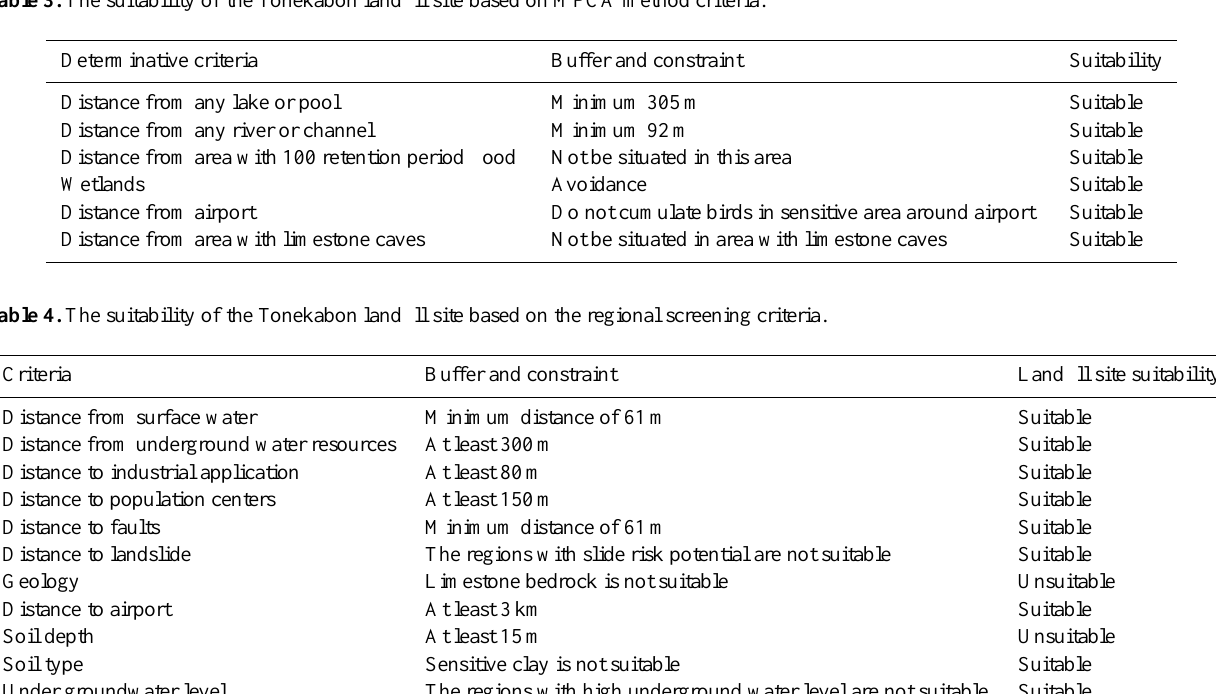
Table 3. The suitability of the Tonekabon landfill site based on MPCA method criteria. Determinative criteria Buffer and constraint